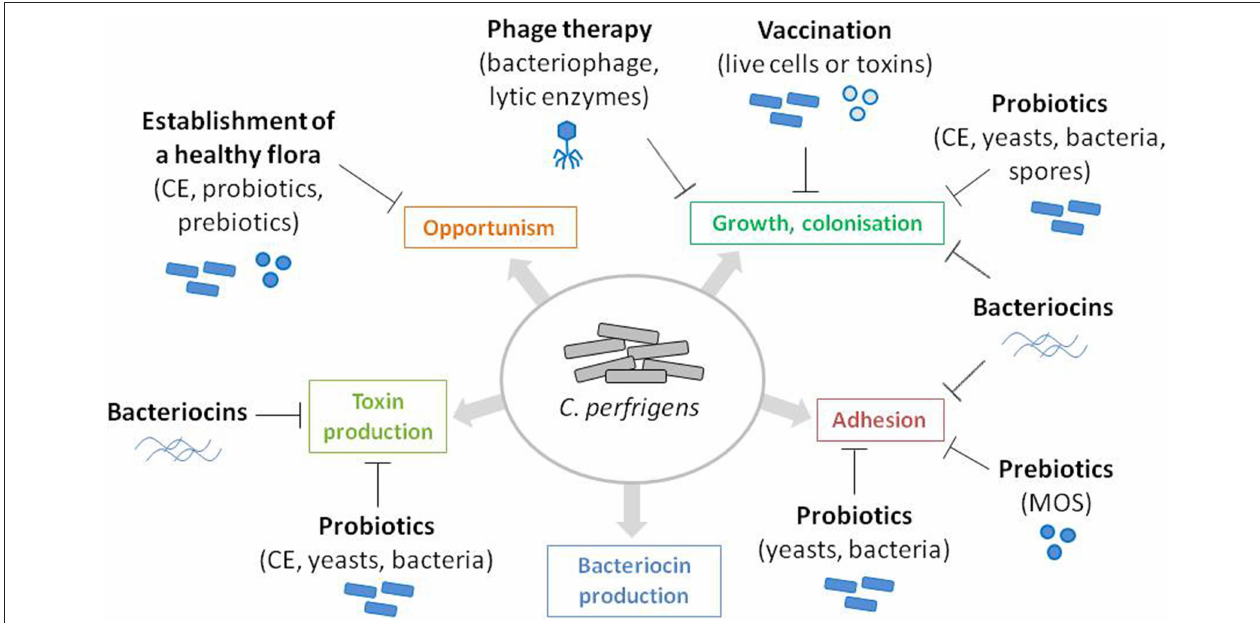
FIGURE 1 | Identification of C. perfringens virulence and pathogenicity factors as potential targets for NE prevention. C. perfringens virulence and pathogenicity factors are represented as colored boxes. Antagonistic action of the microbes and microbe-derived products discussed in this review are represented by flat-end arrows.